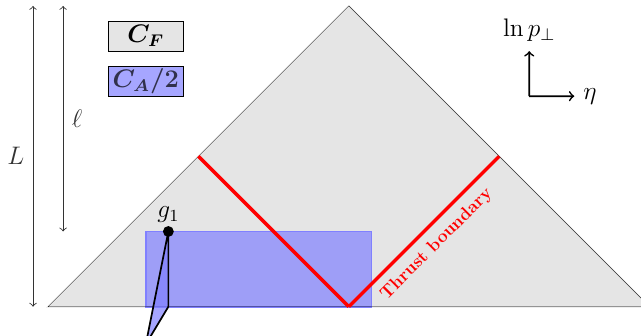
Figure 4. Lund diagram to help illustrate subleading- N c issue for the Thrust. See text for further